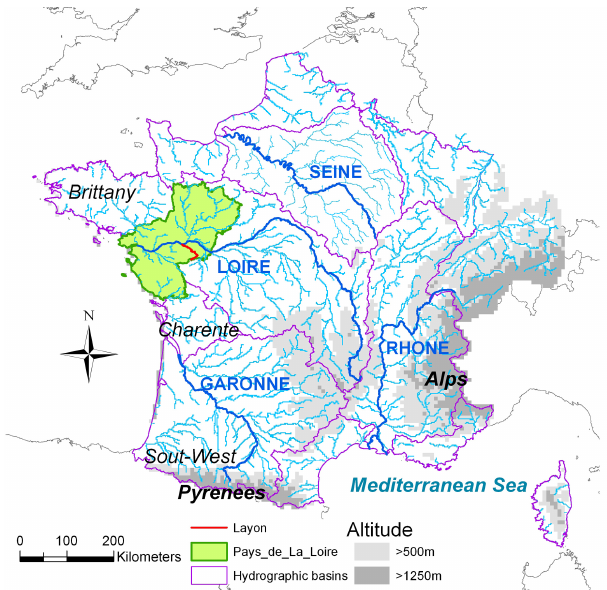
Figure 1. Domain under study. The Pays de la Loire region is shaded in green, and the Layon River is drawn in